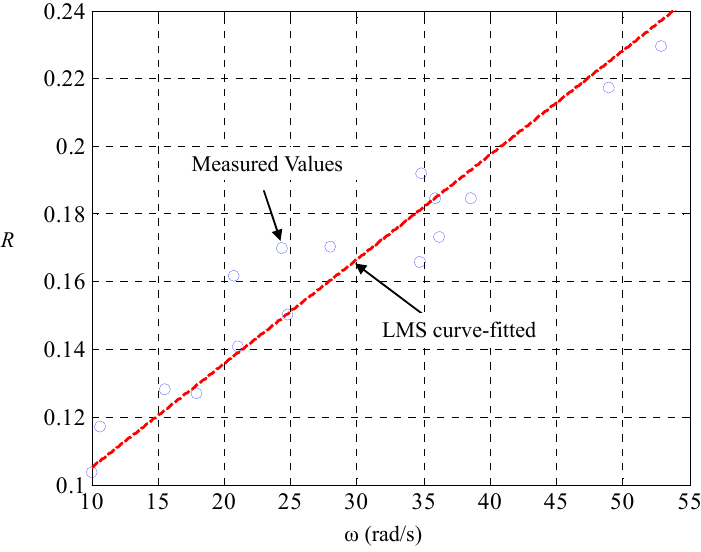
Figure 3. Identification of dependence electric resistance on tire speed.